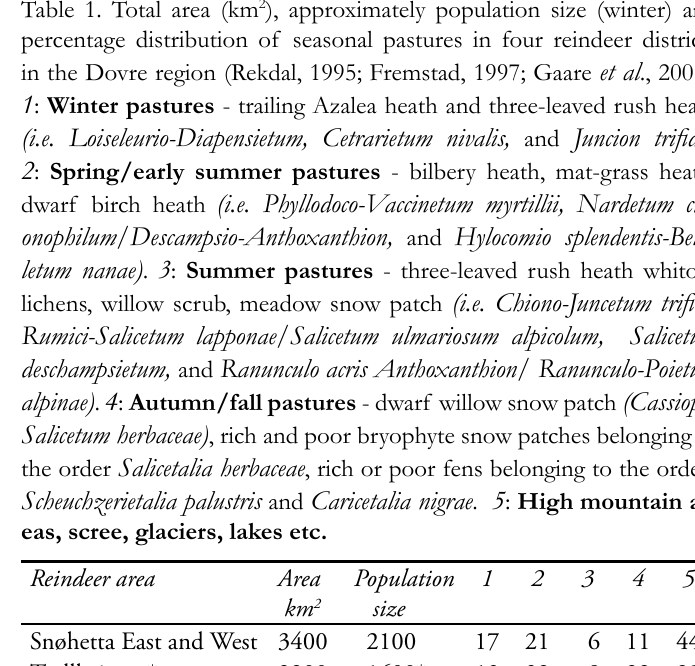
Table 1. Total area (km 2 ), approximately population size (winter) and percentage distribution of seasonal pastures in four reindeer districts in the Dovre region (Rekdal, 15; Fremstad, 17; Gaare et al ., 2001).